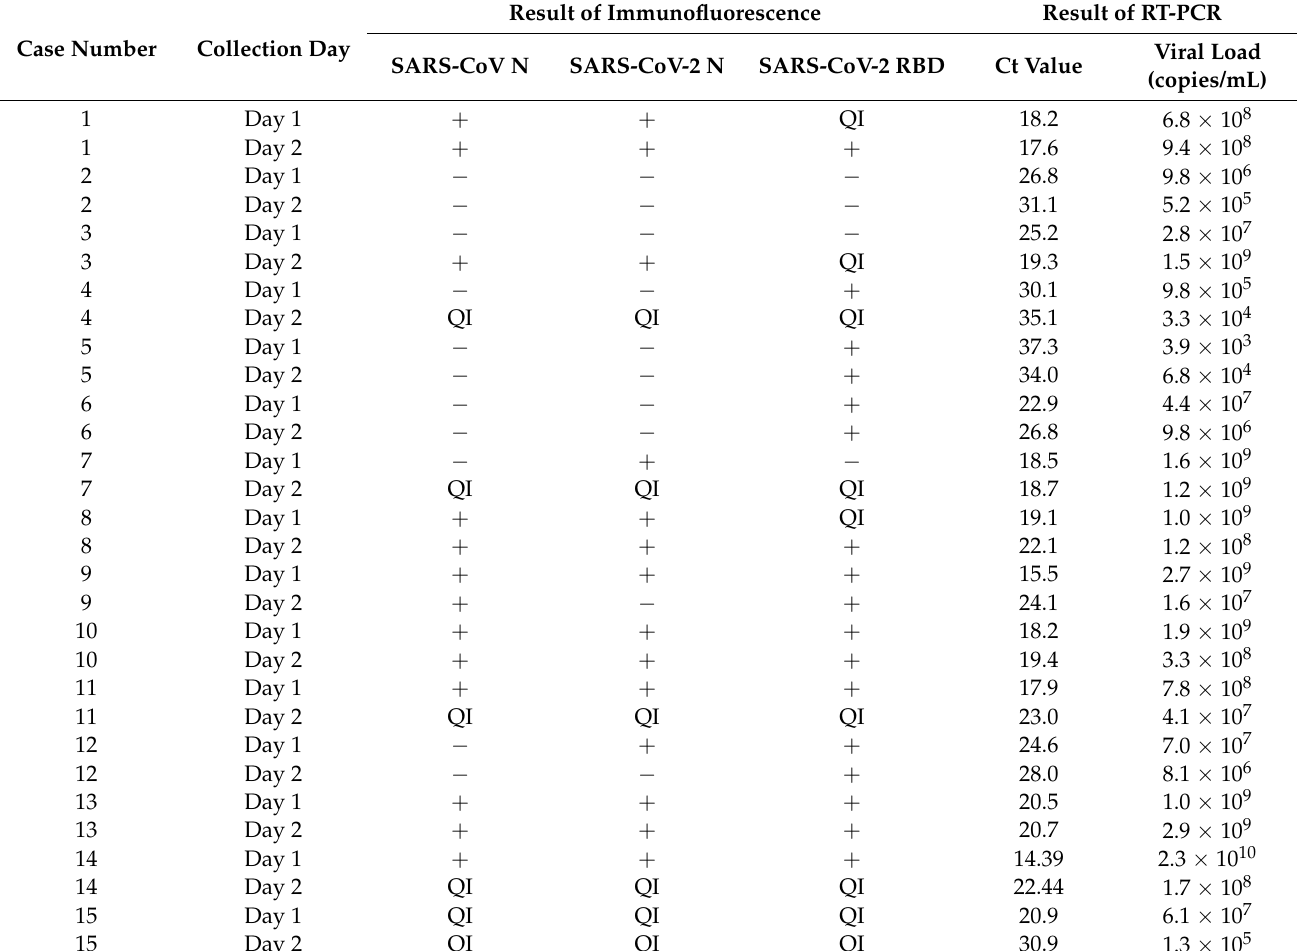
Figure 3. Smears of cells from clinical NPS from COVID-19 patients stained with primary antibody against SARS-CoV-2 RBD (original magnification × 200). ( a ) Smear of cells from COVID-19 patients with positive results. ( b ) Smear of cells from non-infected individuals with positive results indicating non-specificity. Red arrow indicates positive cell. Table 1. Detection of SARS-CoV-2 in cells from NPS samples of COVID-19 patients by indirect immunofluorescence using 3 primary